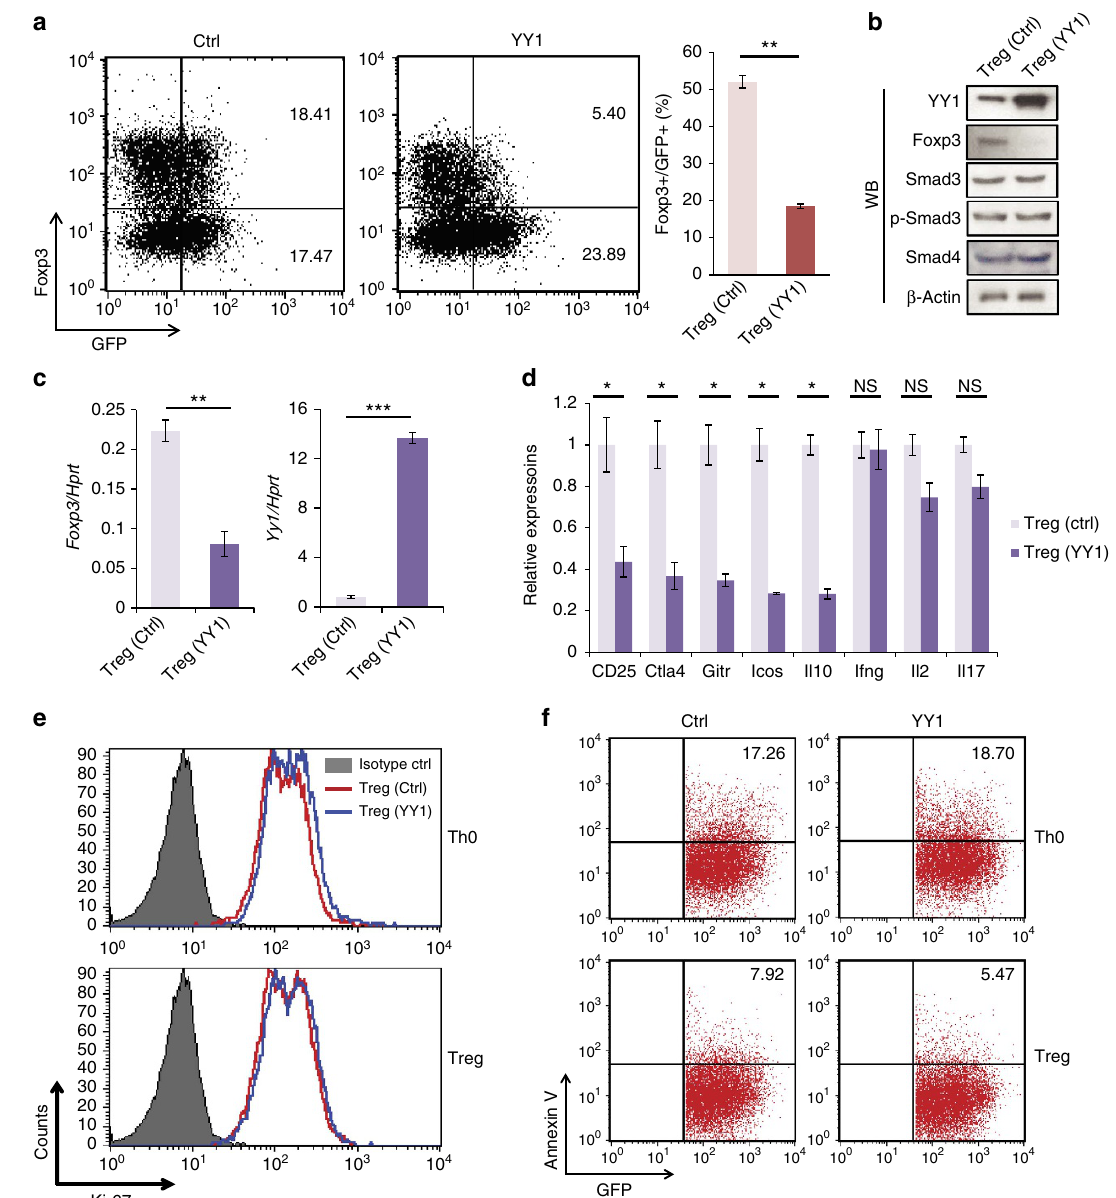
Figure 2 | YY1 overexpression causes a loss of Foxp3 and T reg signature genes. ( a ) WT naı¨ve CD4 T cells were transduced with retroviral vector containing GFP or Yy1 and differentiated into T reg cells for 4 days. Expression of Foxp3 was measured by flow cytometry (left), and the ratio of Foxp3 þ cells in GFP þ cells was shown (right). ( b ) Immunoblot analysis of YY1 and Foxp3 from GFP þ cells. ( c , d ) GFP þ cells from a were sorted, and total RNA was isolated. Relative amounts of the Foxp3 and Yy1 ( c ) and T reg signature genes ( d ) were measured by qRT–PCR. ( e ) Proliferation of control or YY1-transduced Th0 or T reg cells was measured using Ki-67 antibody. Cells were gated on GFP þ expression. ( f ) Apoptosis of control or YY1-transduced Th0 or T reg cells was analysed by Annexin V staining. Experiments were performed three times with similar results. Statistical differences in a and d were analysed by Student’s t -test ( n ¼ 3). * P o 0.05; ** P o 0.01. Error bars shown in a and d represent genes changed more than twofold by YY1 overexpression, we found that more genes were upregulated than were downregulated, except genes related to immune responses or inflammatory responses (Supplementary Fig. 2A), suggesting that YY1 enhances general cellular activities. In the category of genes related to T reg -cell differentiation, more genes were downregulated than were upregulated by YY1 overexpression (Supplementary Fig. 2B), consistent with our quantitative reverse transcription–PCR (qRT–PCR) data (Fig. 2c,d). Proliferation and cell death of YY1-transduced Th0 and T reg cells were examined using anti-Ki-67 antibody and Annexin V, respectively.